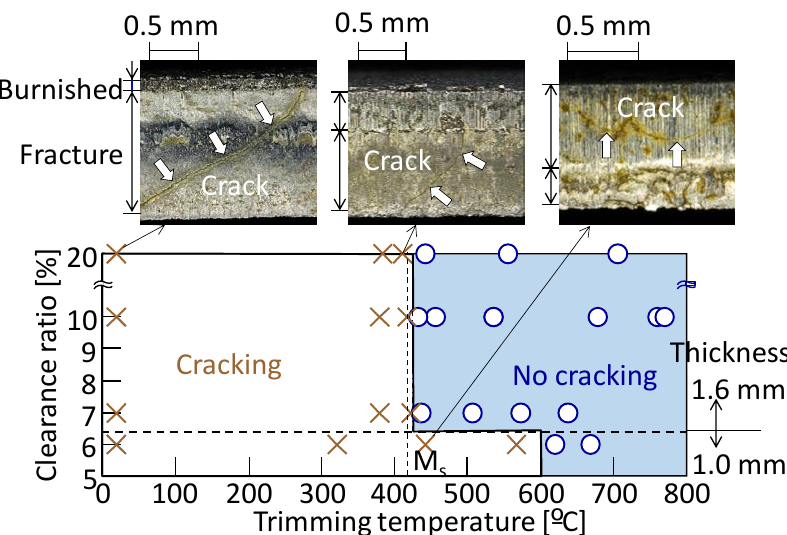
Figure 14. Delayed cracking induced by cathodic hydrogen charging test of hot-trimmed 22MnB5 quenchable steel sheet [73].